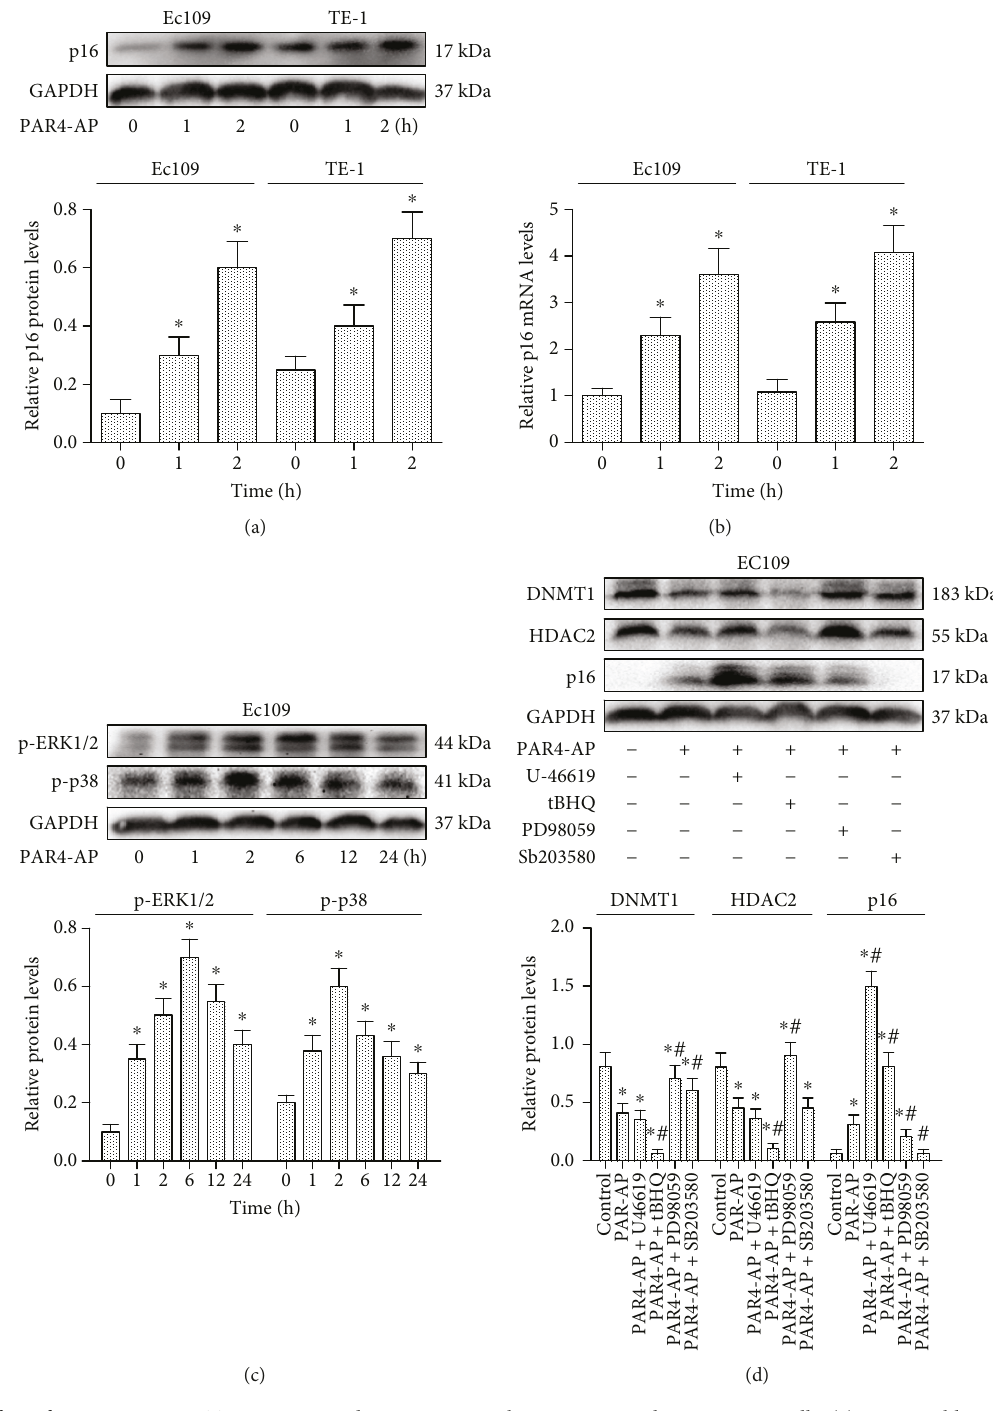
Figure 2: E ff ect of MAPK on DNMT1, HDAC2, and p16 expression by PAR4-AP in human ESCC cells. (a) Western blotting showing p16 protein levels in ESCC cell lines (EC109 and TE-1) with PAR4-AP treatment at 0, 1, and 2 h, respectively. (b) RT-PCR analysis showing p16 gene levels in ESCC cell lines (EC109 and TE-1) with PAR4-AP treatment at 0, 1, and 2 h, respectively. The results were calculated by normalizing to β -actin in the same sample with the Δ Ct method. The changes in the relative mRNA levels are expressed as fold changes compared with the controls. (c) Western blotting showing p-ERK1/2 and p-p38 expression in ESCC cells with PAR4-AP treatment at 0, 1, 2, 6, 12, and 24h, respectively. (d) Western blotting analyses for DNMT1, HDAC2, and p16 protein expressions in ESCC cells following treatment with PAR4-AP for 2 h and pretreatment with U-46619 (an activator of ERK1/2 and p38), tBHQ (an activator of ERK1/2), PD98059 (an inhibitor of ERK1/2), or SB203580 (an inhibitor of p38) for 60 min. The mean optic densities of the proteins were calculated by normalizing to GAPDH. All values are expressed as the means ± SEMs ( n = 3 ). ∗ P < 0 05 versus controls; # P < 0 05 versus PAR4-AP- only